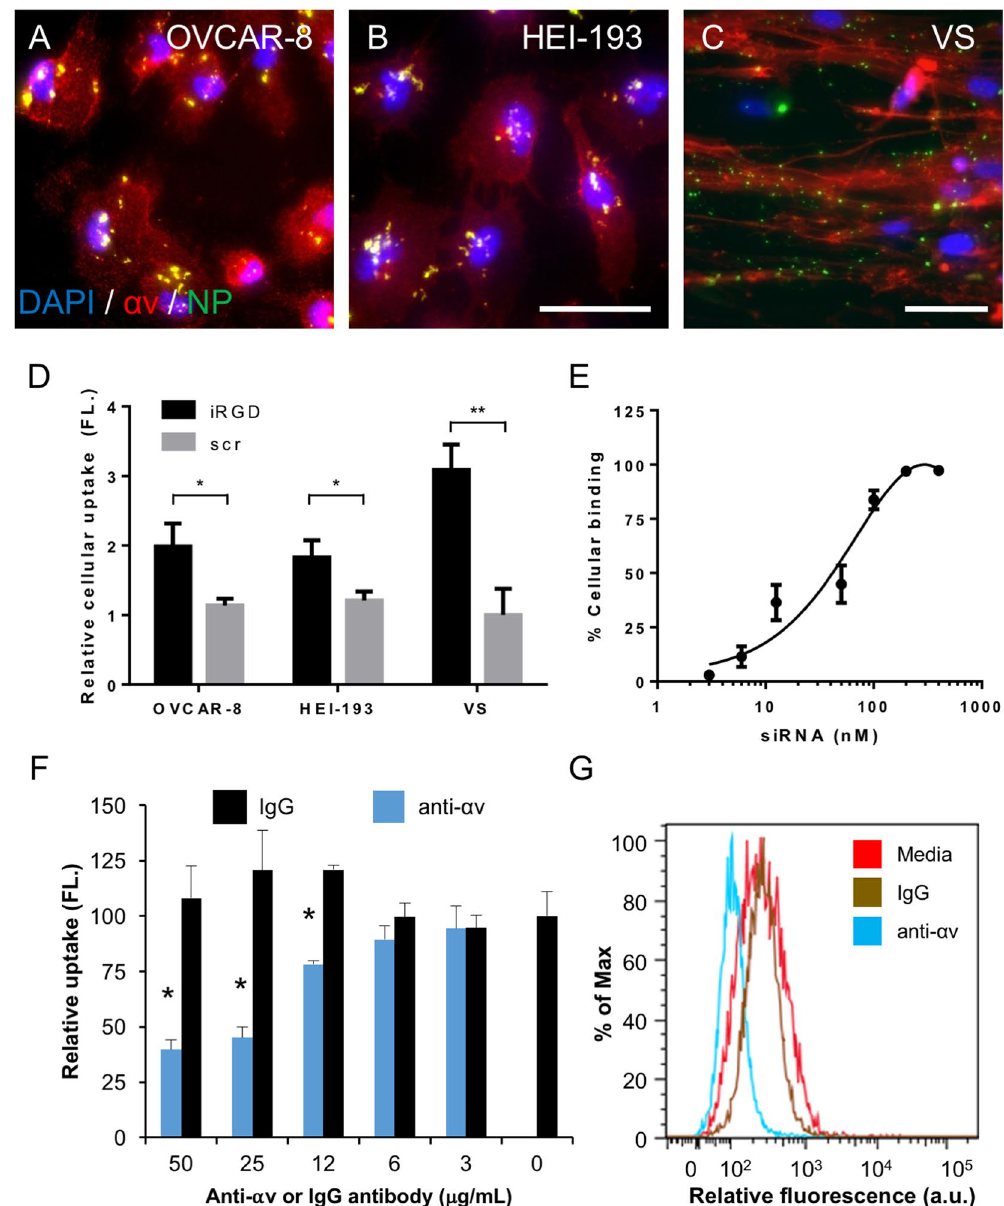
Figure 5. Receptor-specific targeting of iRGD nanoparticles in cancer cell lines and primary human vestibular schwannoma cells. ( A – C ) Representative immunocytochemistry images of nanoparticle uptake in OVCAR-8 cells ( A , based on 6 different experiments), HEI-193 cells ( B , based on 6 different experiments), and human vestibular schwannoma cells ( C , based on 4 biological replicates from different patients) in vitro . Red, α v integrin. Green, nanoparticle (NP) with siRNA labeled with a fluorescent dye (Alexa Fluor 647). Blue, DAPI nuclear stain. Yellow pseudocolor suggests co-localization between siRNAs and α v integrin receptors. Scale bar, 100 μ m. ( D ) Quantification of cellular uptake of iRGD targeted nanoparticles (iRGD, black bars) versus control nanoparticles (scr, gray bars) in OVCAR-8 cells, HEI-193 cells, and human VS cultures. Error bars represent standard deviation. N = 4–6 independent replicates. * P < 0.05, ** P < 0.01, Student’s two-tailed t-test. ( E ) Dose-dependence of nanoparticle binding in HEI-193 cells as determined by flow cytometry. Calculated K d is approximately 41 nM from the binding curve. ( F ) HEI-193 cellular uptake of iRGD-targeted nanoparticles is inhibited by an antibody directed against α v integrin (blue bars) in a dose-dependent manner. A control antibody, IgG (gray bars) had no significant effect. N = 6 independent replicates. * P < 0.05, Student’s two-tailed t-test. ( G ) Representative flow cytometry histograms of cellular uptake of fluorescently-labeled siRNA in the presence of a blocking anti- α v integrin antibody (blue), control IgG (brown), or culture medium